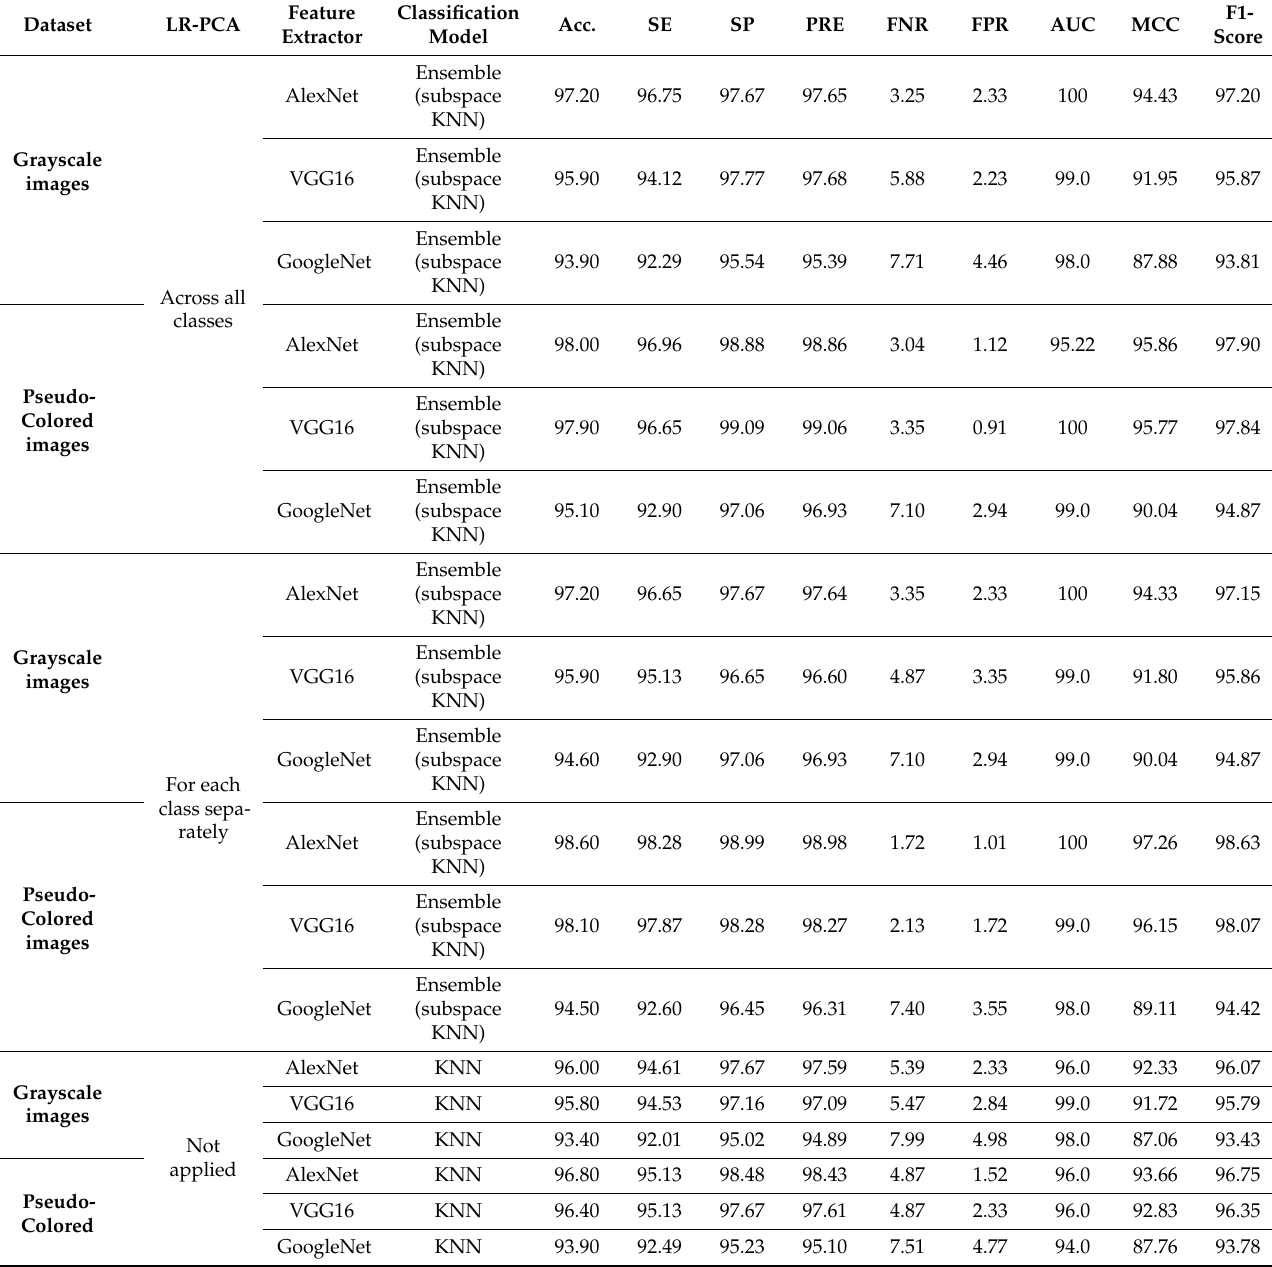
Table 2. Classification evaluation performance (%) of the proposed CAD system with three different backbone deep learning classifiers. These results were derived using INbreast